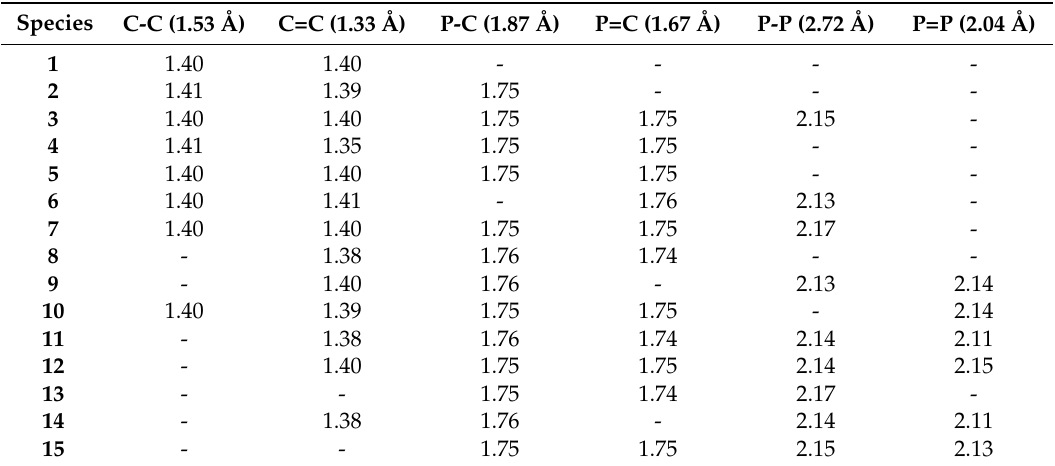
Table 1. Average bond lengths (in Å) at the B3LYP/6-31+G(d) level.